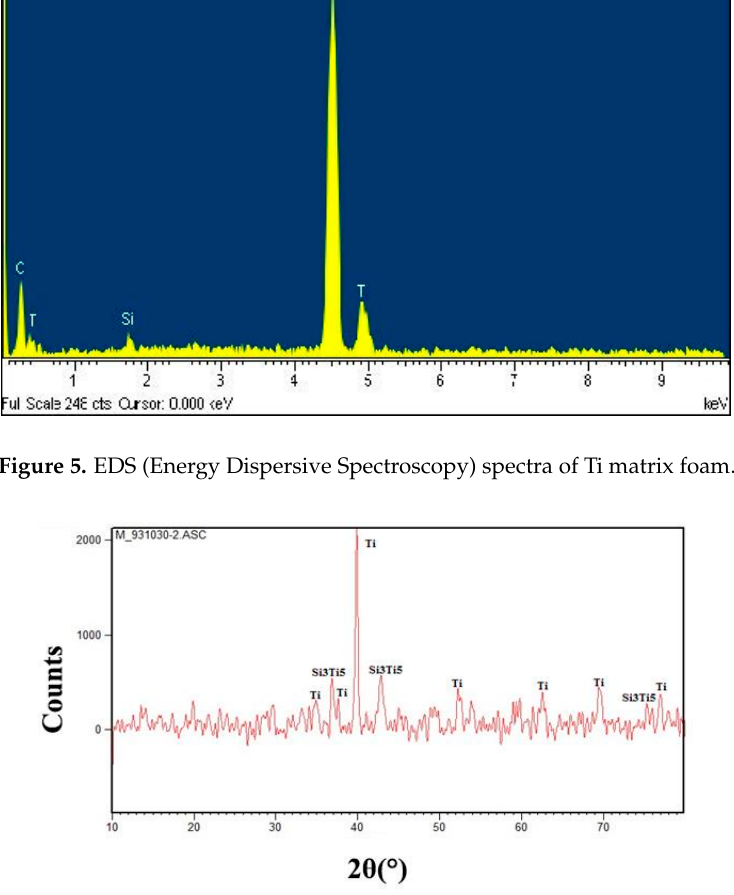
Figure 6. Typical XRD ( X-ray diffraction) pattern of Ti-matrix foam.